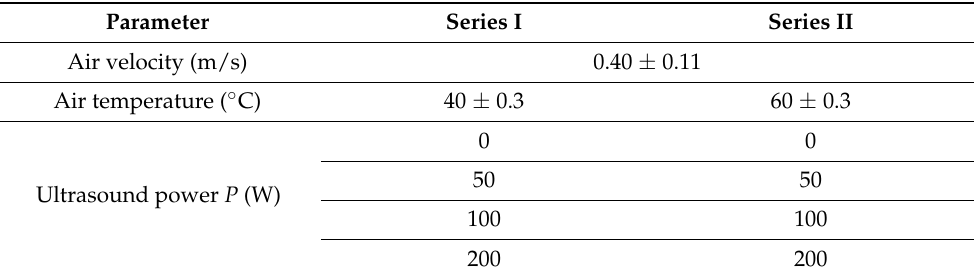
Table 2. Processes